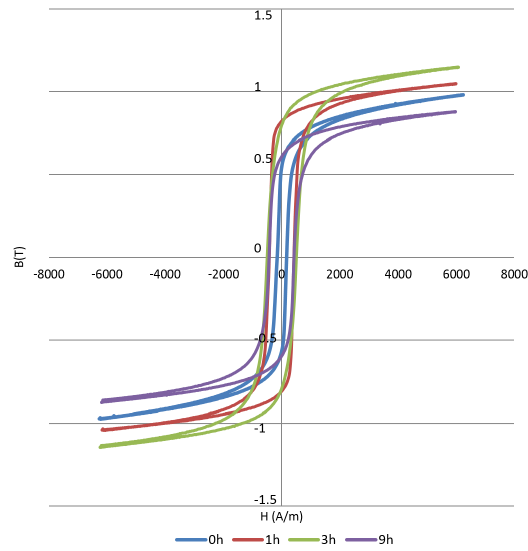
Figure 8. Hysteresis curve B x H of ferrous alloy, with different milling times.